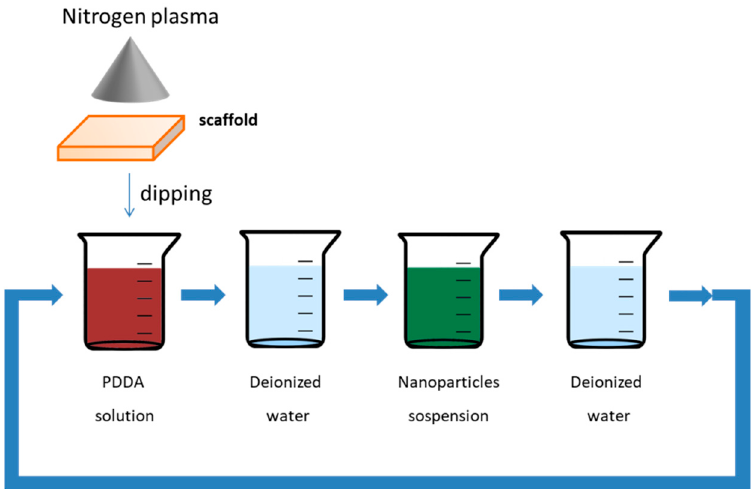
Figure 1. Schematic representation of the procedure used to fabricate the paramagnetic scaffolds [88].